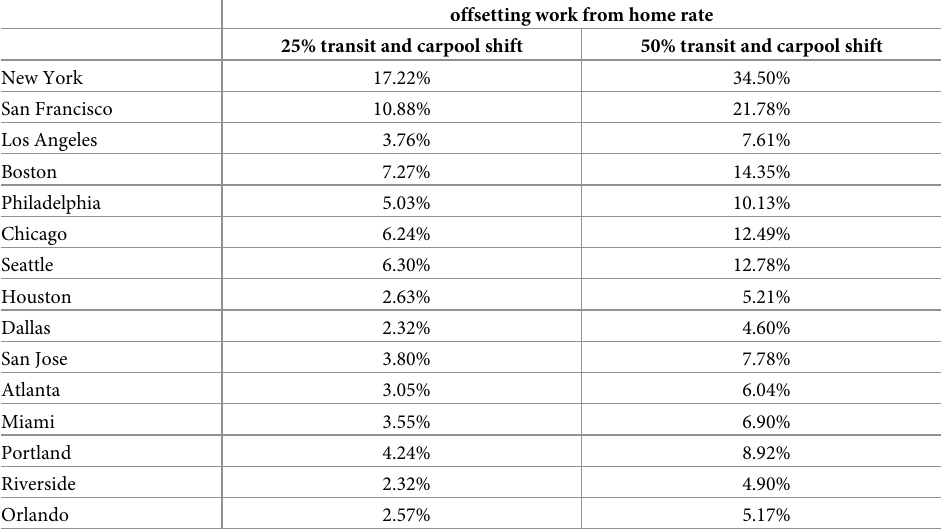
Table 5. Percent of potential SOV commuters that are required to work-from-home to offset congestion increases due to 25% and 50% shifts away from transit and carpool into SOV. See also S5 Table for all 74 modeled metro